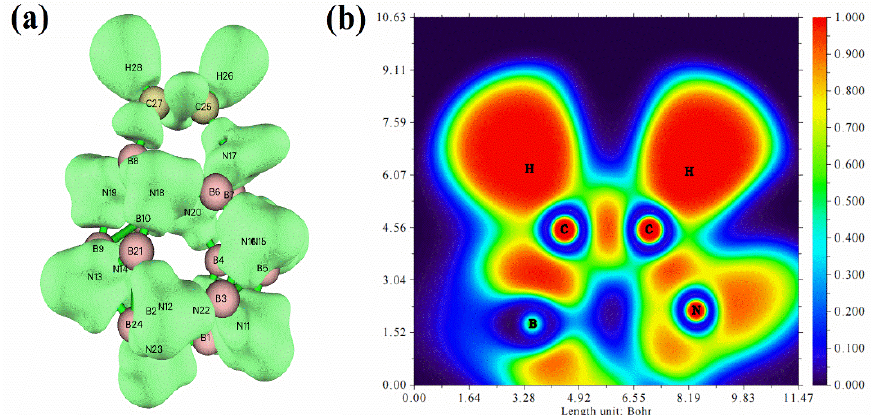
Figure 12. Electron localization function (ELF) of acetylene adsorbed on B 12 N 12 nanocages (( a ) is the global ELF diagram of acetylene adsorption structure on B 12 N 12 NC, ( b ) is the local ELF isosurface diagram of acetylene adsorption site).